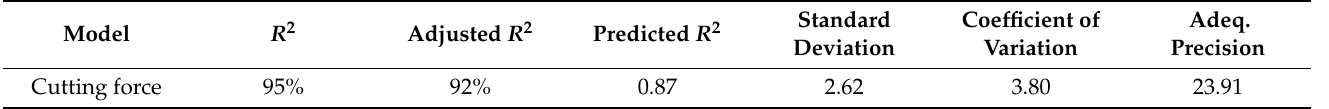
Table 5. Fit statistics for resultant force